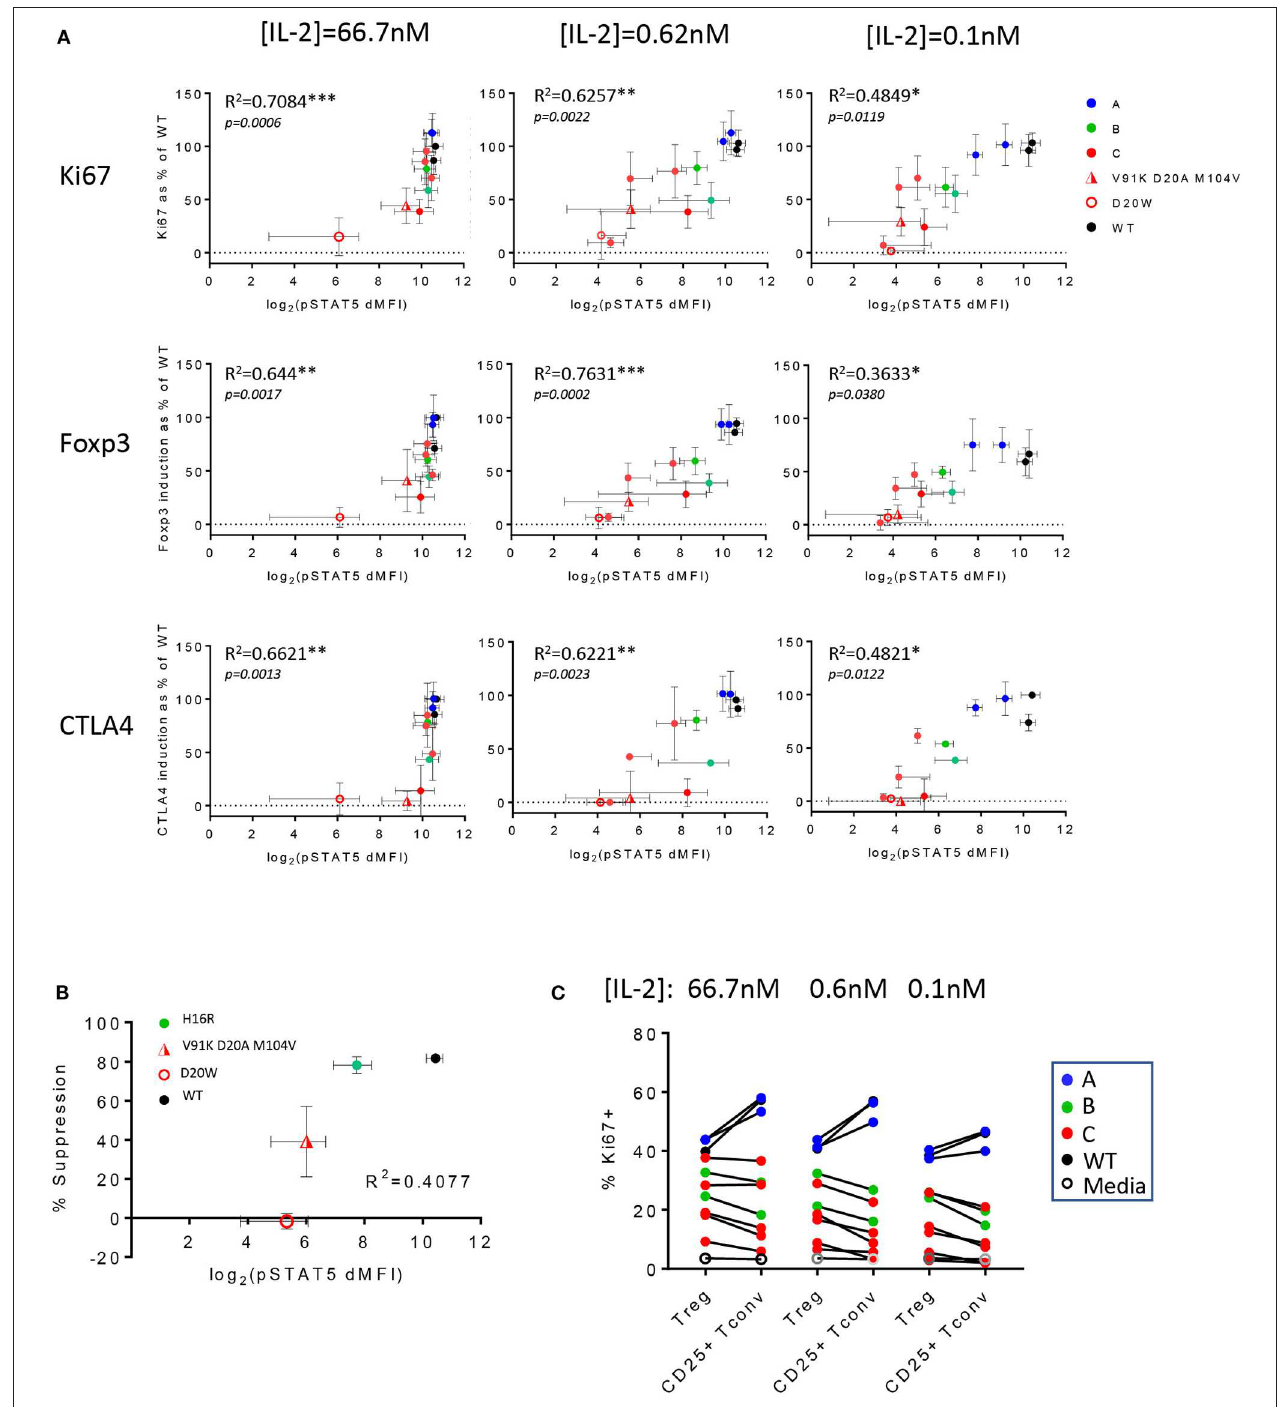
FIGURE 6 | Treg cell functional responses are variably sensitive to IL-2 activity. (A) In vitro Treg cell proliferation (percent Ki67 positive of Treg cells) and Foxp3 and CTLA4 expression (MFI of Foxp3 + or CTLA4 + cells in Treg population) at IL-2 concentrations 66.7, 0.62, and 0.1nM were converted to % response relative to wildtype IL-2 at 66.7nM as the reference and plotted against pSTAT5 MFI (in log2 scale) values that were generated from the whole blood cell assay. The data are combined results from three different donors. The error bars indicate standard deviation. R 2 values were calculated from Pearson r generated by correlation analysis, and the corresponding p -values are shown. Data points are color-coded by class, except the two weakest muteins (V91K D20A M104V and D20W). (B) Correlation plot of in vitro suppression and pSTAT5 signal in Treg cells. The y-axis represents the percent suppression of CD8T cell activation read out by inhibition of activation marker expression in an 1-day Treg:CD8T coculture assay at [IL-2] = 66.7nM and Treg:CD8T ratio of 1:1. One class B mutein (H16R) and the two weaker class C